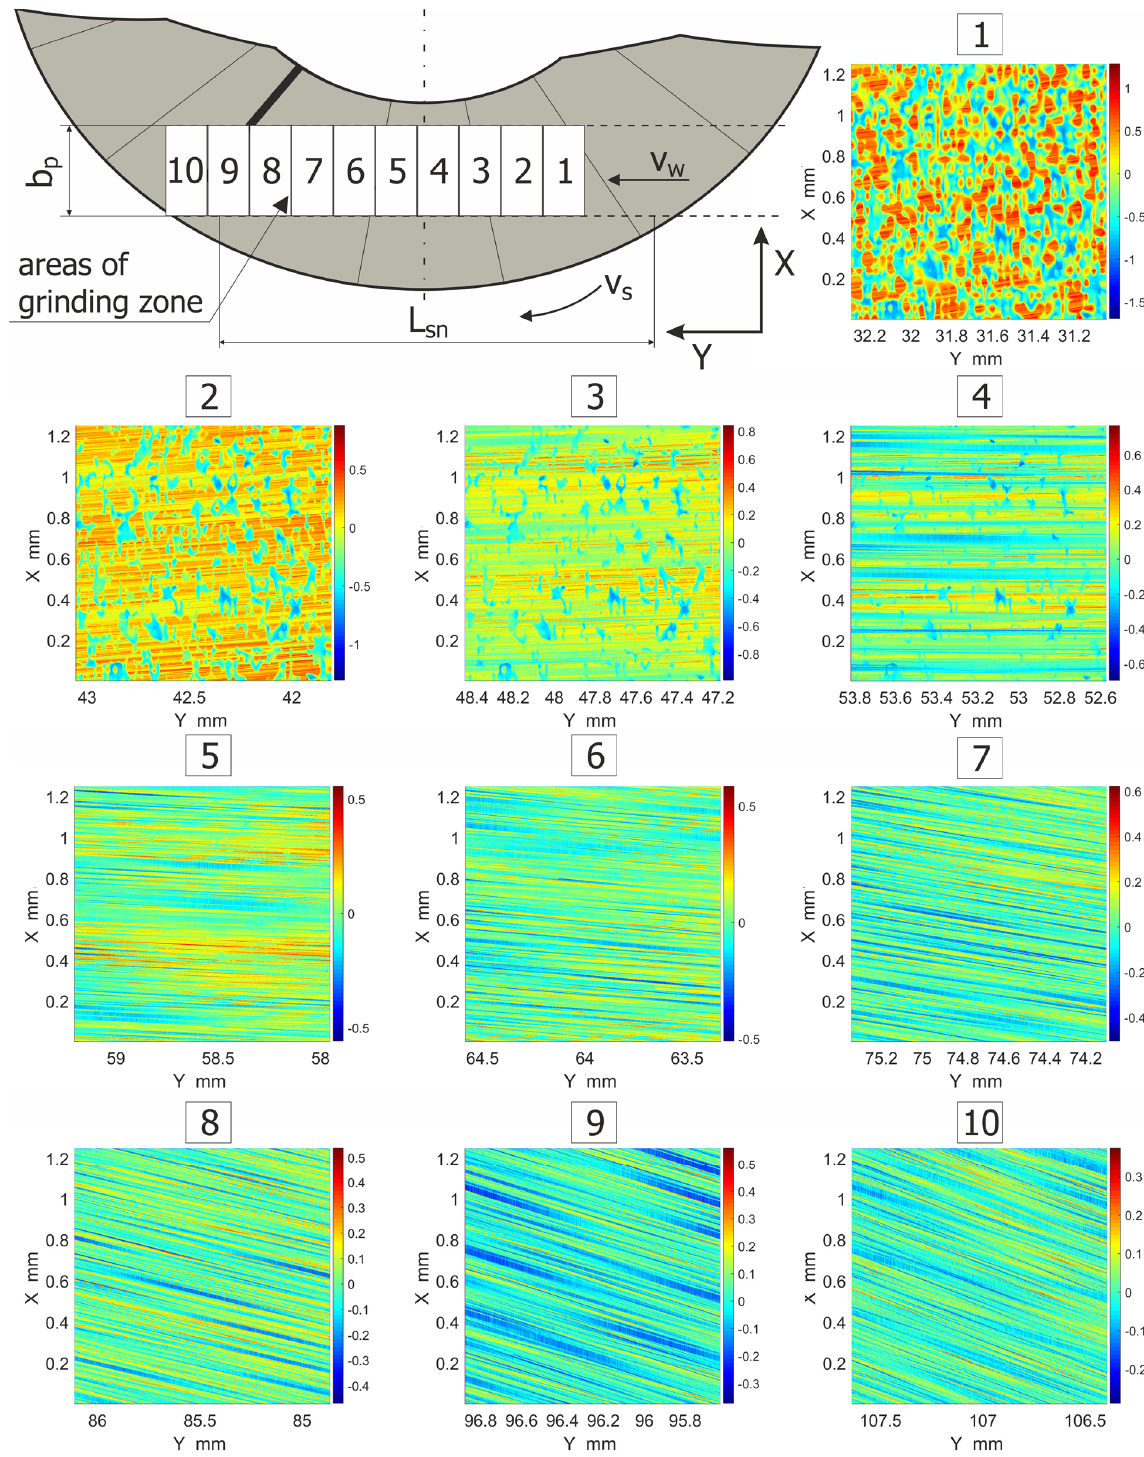
Figure 11. Patterns of the machining traces for selected areas from the ground surfaces.